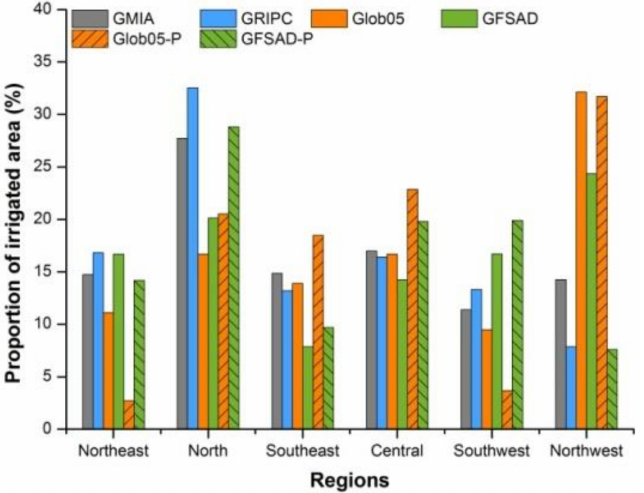
Figure 2. Regional ratios of irrigated croplands.